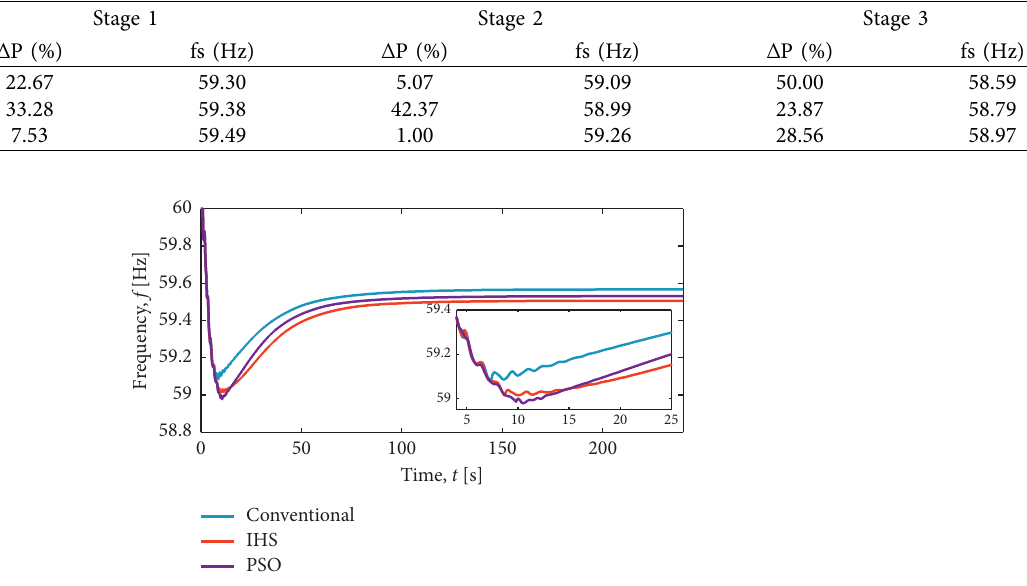
Figure 11: Frequency response after the activation of the UF-relays for conventional UFLS approach and optimal UFLS approach solved by PSO and IHS algorithms. Table 5: Summary of frequency response indicators and the total amount of LS of conventional and optimal UFLS